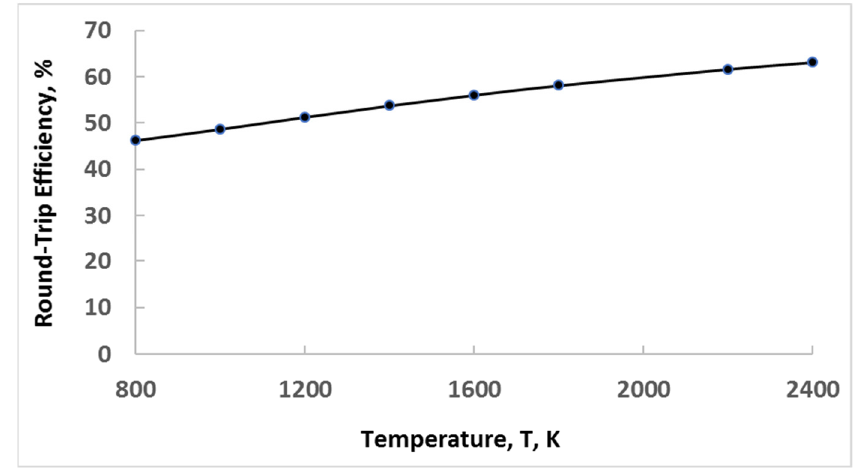
Figure 5. Round-trip efficiency of a CAES at 80 bar with variable turbine inlet temperature.